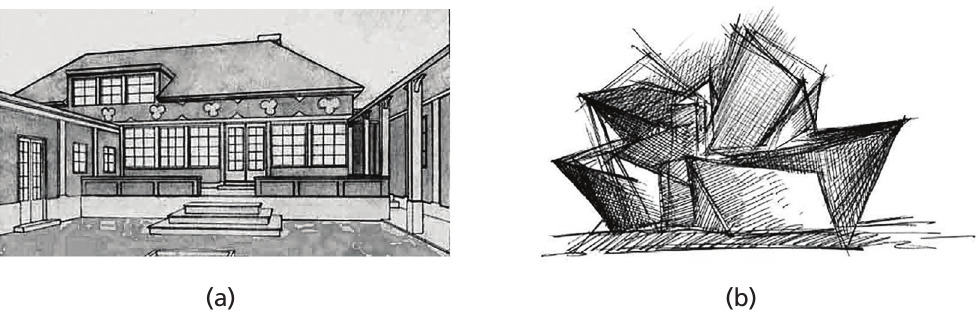
Figure 20. ( a ) Christopher Alexander drawing for the Anderson house project, an unfolded structure. Source: patternlanguage.com; ( b ) drawing by Daniel Libeskind of Denver Art Museum from The Denver Post , 6 December